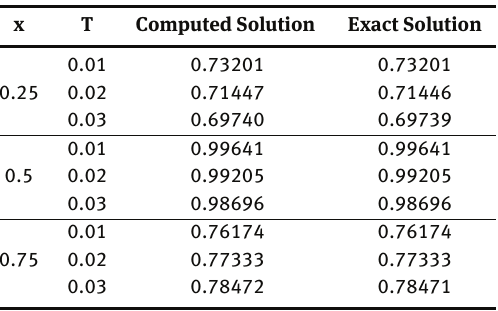
Table 5: Comparison of exact solution and the computed numerical solution at different times for Example-2 at ν = 0.04 , Δx = 0.0125 and Δt = 0.001 .